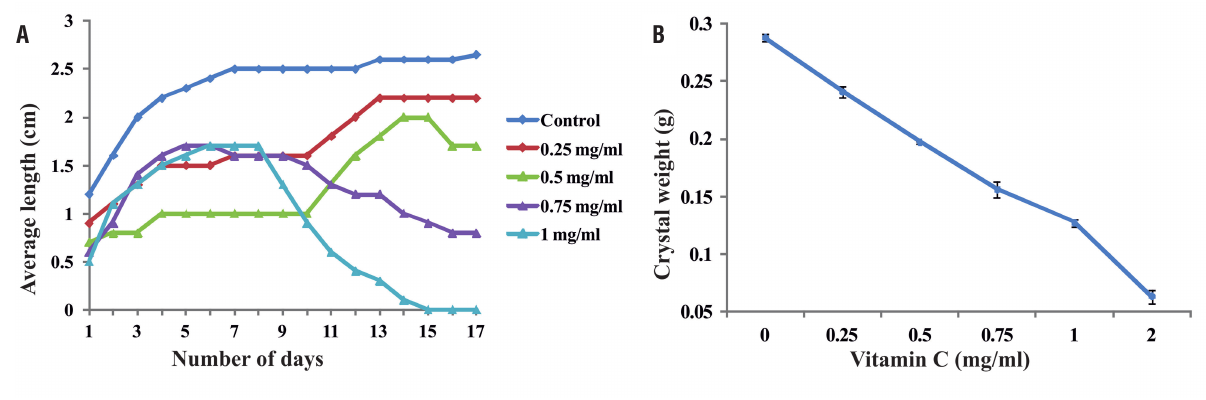
Figure 4 - Relationship between vitamin C concentrations and (a) length and (b) weight of struvite crystals obtained in gel growth technique.